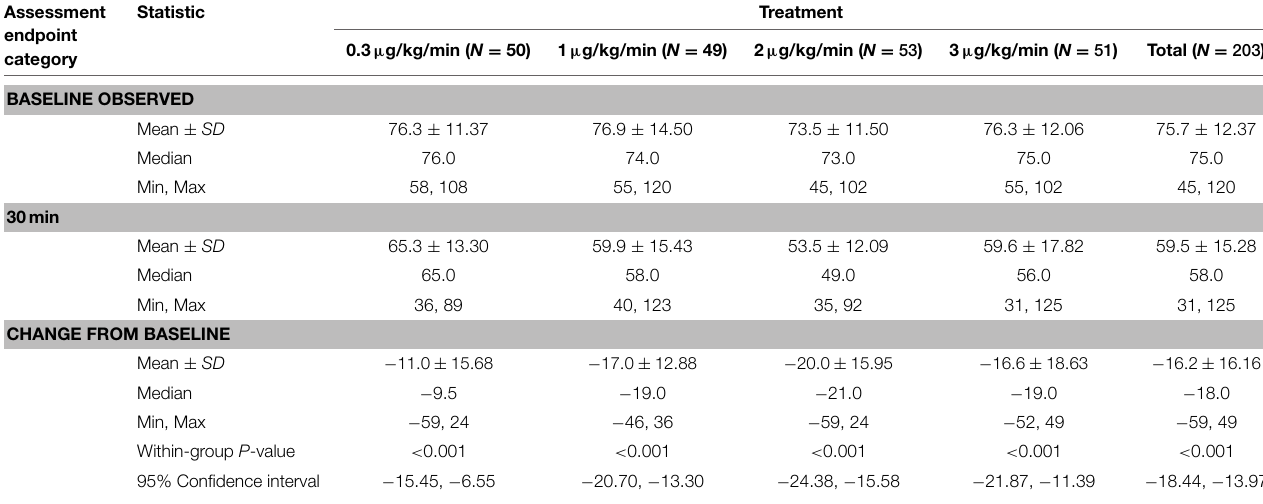
TABLE 3 | Primary efficacy—change from baseline in MAP (mm Hg) after 30min double-blinded infusion. Assessment endpoint